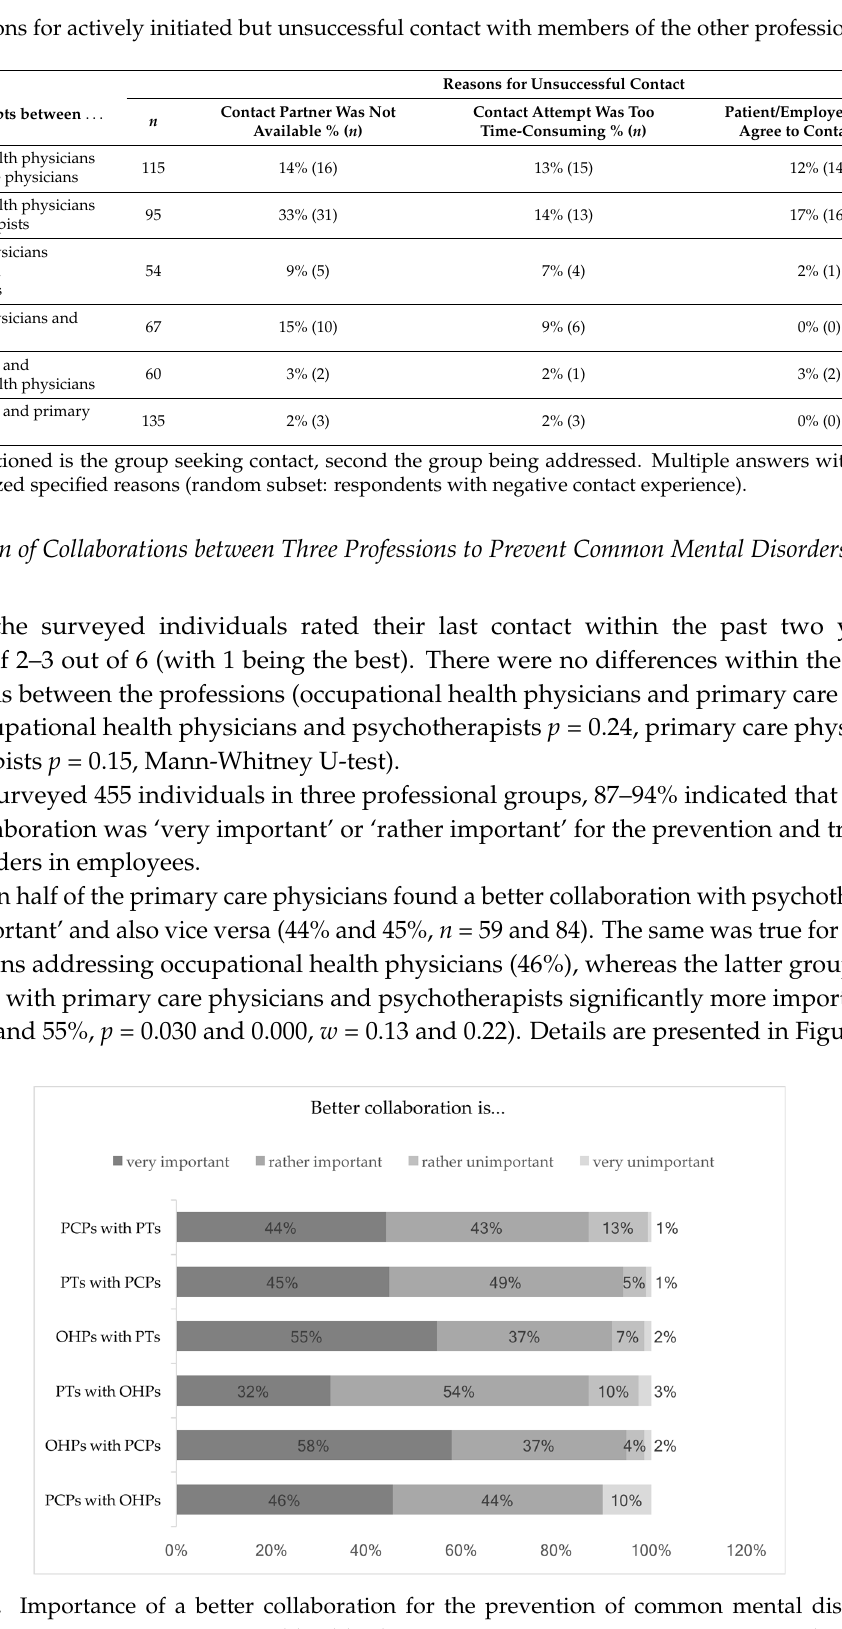
Table 3. Reasons for actively initiated but unsuccessful contact with members of the other professional groups.